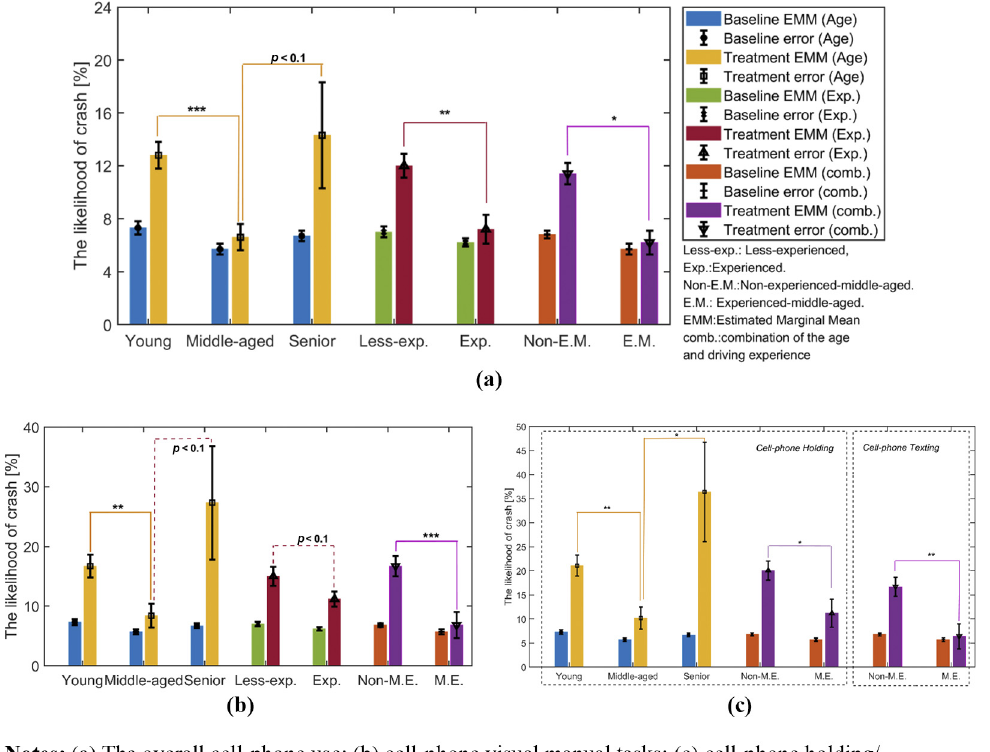
Figure 4 EMMs of the crash risk regarding the cell phone use (signi fi cance level: (cid:5)(cid:5)(cid:5) P < 0.001, (cid:5)(cid:5) P < 0.01, (cid:5) P <